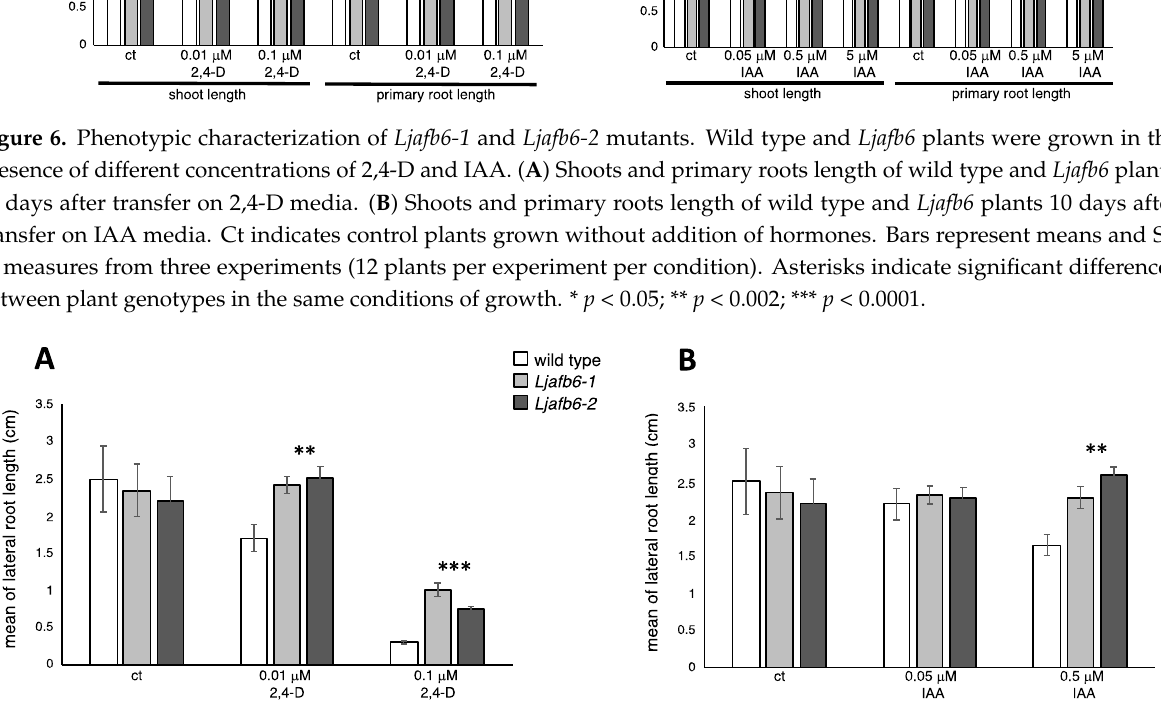
Figure 7. Phenotypic characterization of Ljafb6-1 and Ljafb6-2 mutants. ( A ) Mean of lateral roots length of wild type and Ljafb6 plants 20 days after transfer on 2,4-D media. ( B ) Mean of lateral roots length of wild type and Ljafb6 plants 20 days after transfer on IAA media. Bars represent means and SE of measures from three experiments (12 plants per experiment per condition). Asterisks indicate significant differences between plant genotypes in the same conditions of growth. ** p < 0.002; *** p < 0.0001.